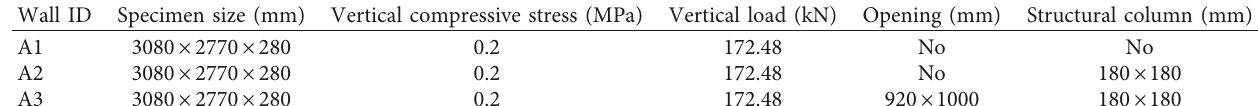
Table 1: Wall specimens’ details.